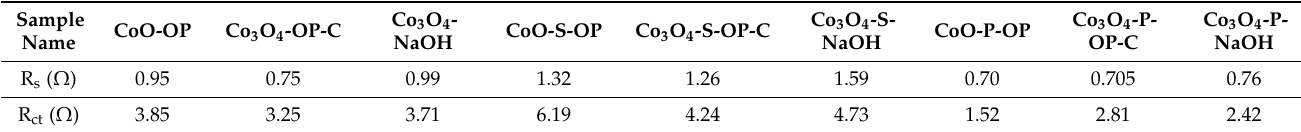
Figure 6. ( a ) EIS, ( b ) specific capacitance vs. current density, ( c ) power density vs. energy density, of all the prepared samples ( d ) Stability curve for the CoO-P-OP sample. Table 1. The calculated values of Rs and R ct for the fabricated electrodes.